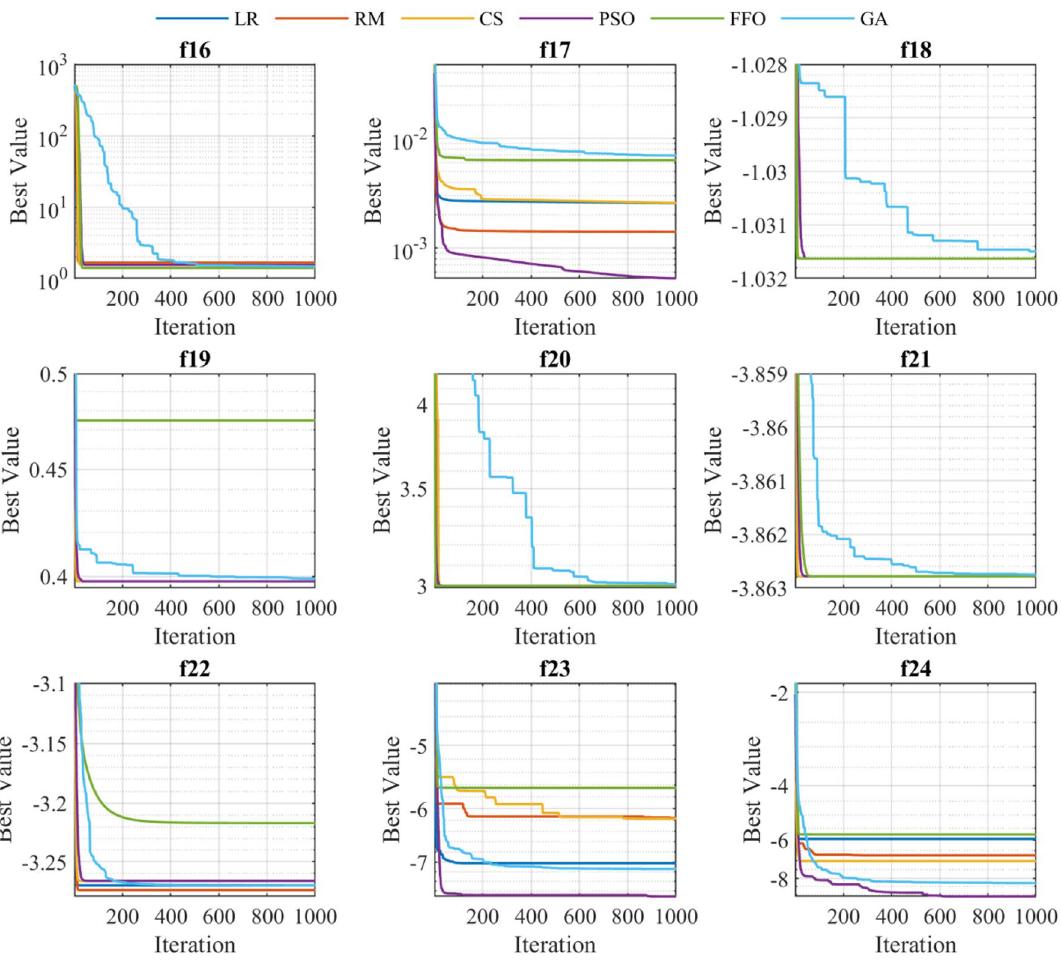
Figure 8. Convergence behaviour of the fixed-multimodal benchmark functions.